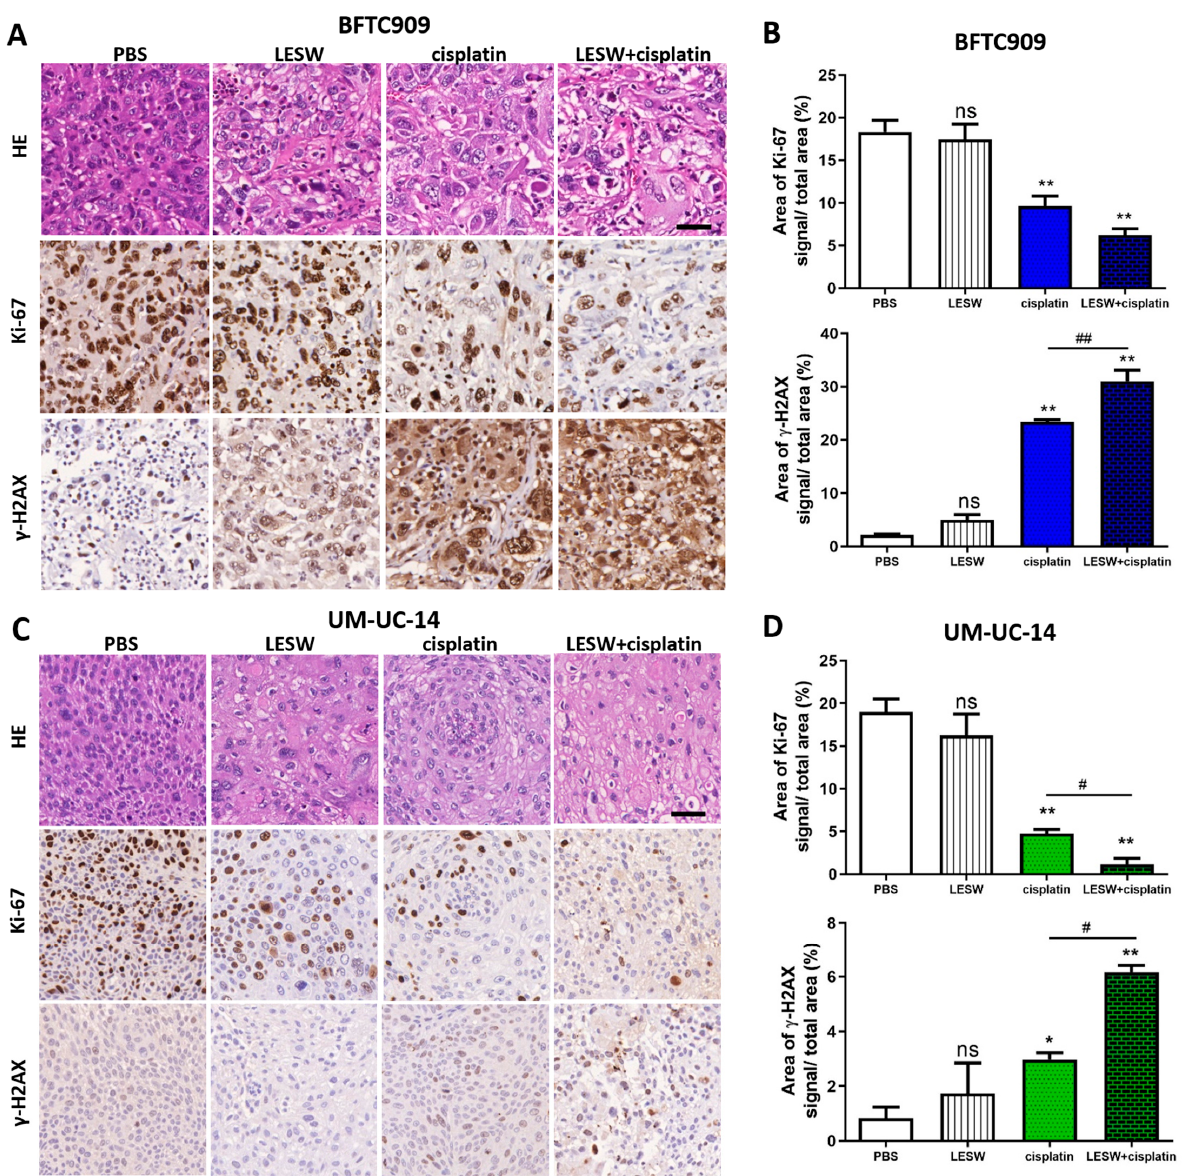
Figure 3. Histopathologic characteristics and immunohistochemical analyses of Ki-67 and γ -H2AX in UTUC cell line–derived tumour xenografts. HE staining and immunostaining of Ki-67 and γ -H2AX in BFTC909 ( A ) and UM-UC-14 ( C ) xenograft tumours in SCID mice. Immunodetectable proteins were stained brown, and the nuclei were counterstained blue. Scale bars indicate 40 μ m. Statistical analysis of the percentage of Ki-67 and γ -H2AX signal area of the four groups in BFTC909 ( B ) and UM-UC-14 ( D ) xenografts. Error bars represent mean ± S.E.M., * p < 0.05, ** p < 0.01 versus control group; ns indicates no significance, # p < 0.05 versus CDDP group, ## p < 0.01 versus CDDP